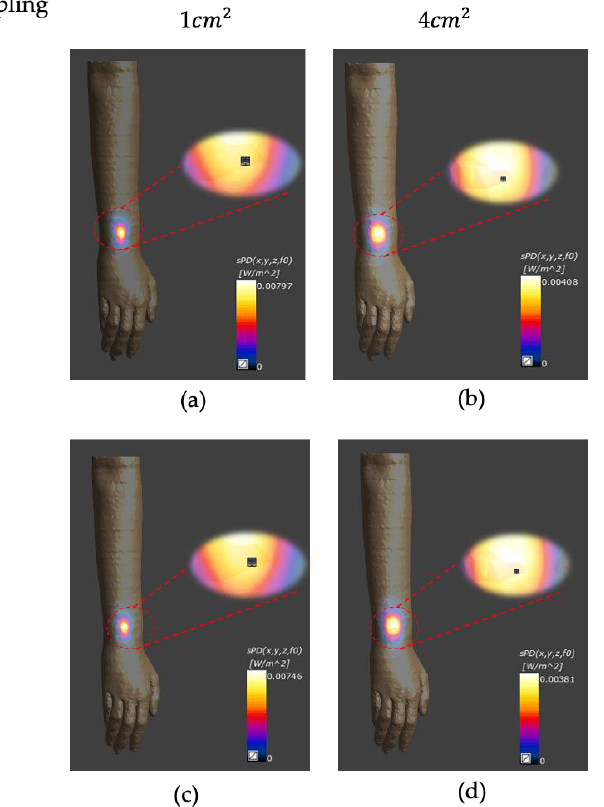
Figure 20. Power density simulation. ( a ) Port 1 feed-in with a sample area of 1 cm 2 , ( b ) port 1 feed-in with a sample area of 4 cm 2 , ( c ) port 3 feed-in with a sample area of 1 cm 2 , and ( d ) port 3 feed-in with a sample area of 4 cm 2